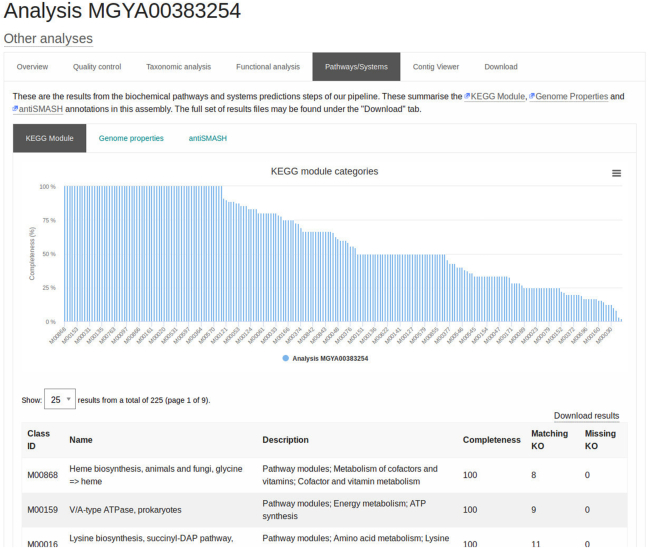
Screenshot showing the percentage completion for a series of KEGG pathways based on the presence of KEGG orthologues, https://www.ebi.ac.uk/metagenomics/analyses/MGYA00383254#path-systems.